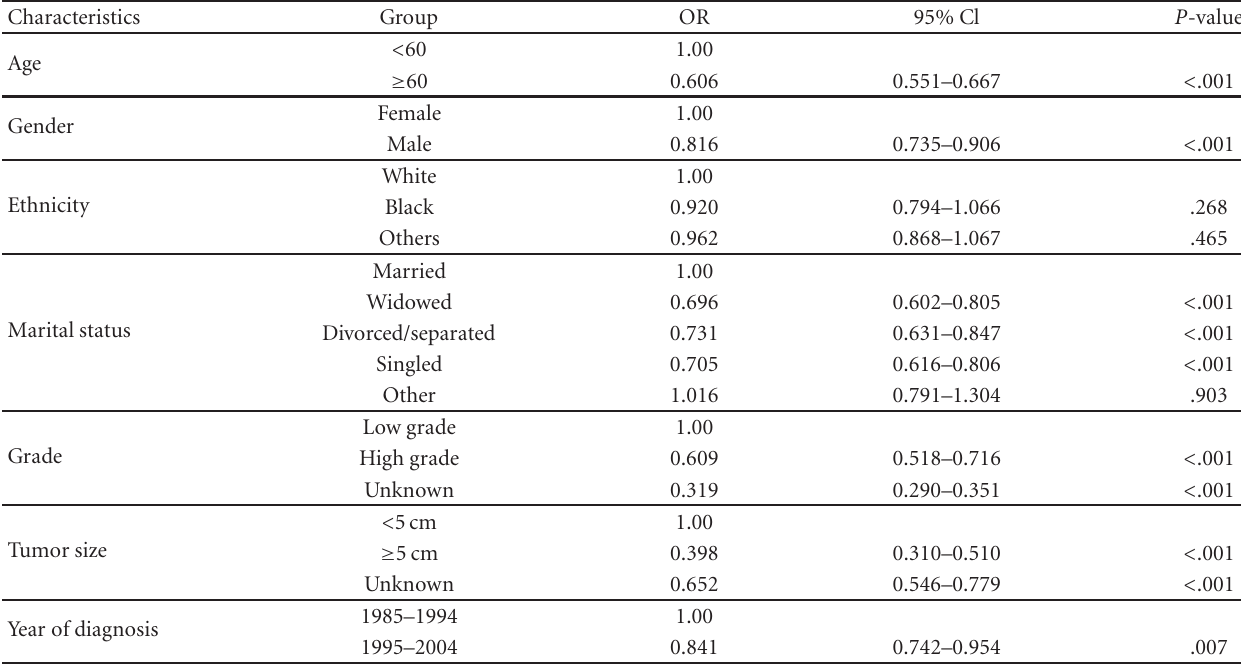
Table 3: Logistic regression analysis of factors associated with recommendation of cancer-directed surgery in patients with localized HCC. Characteristics